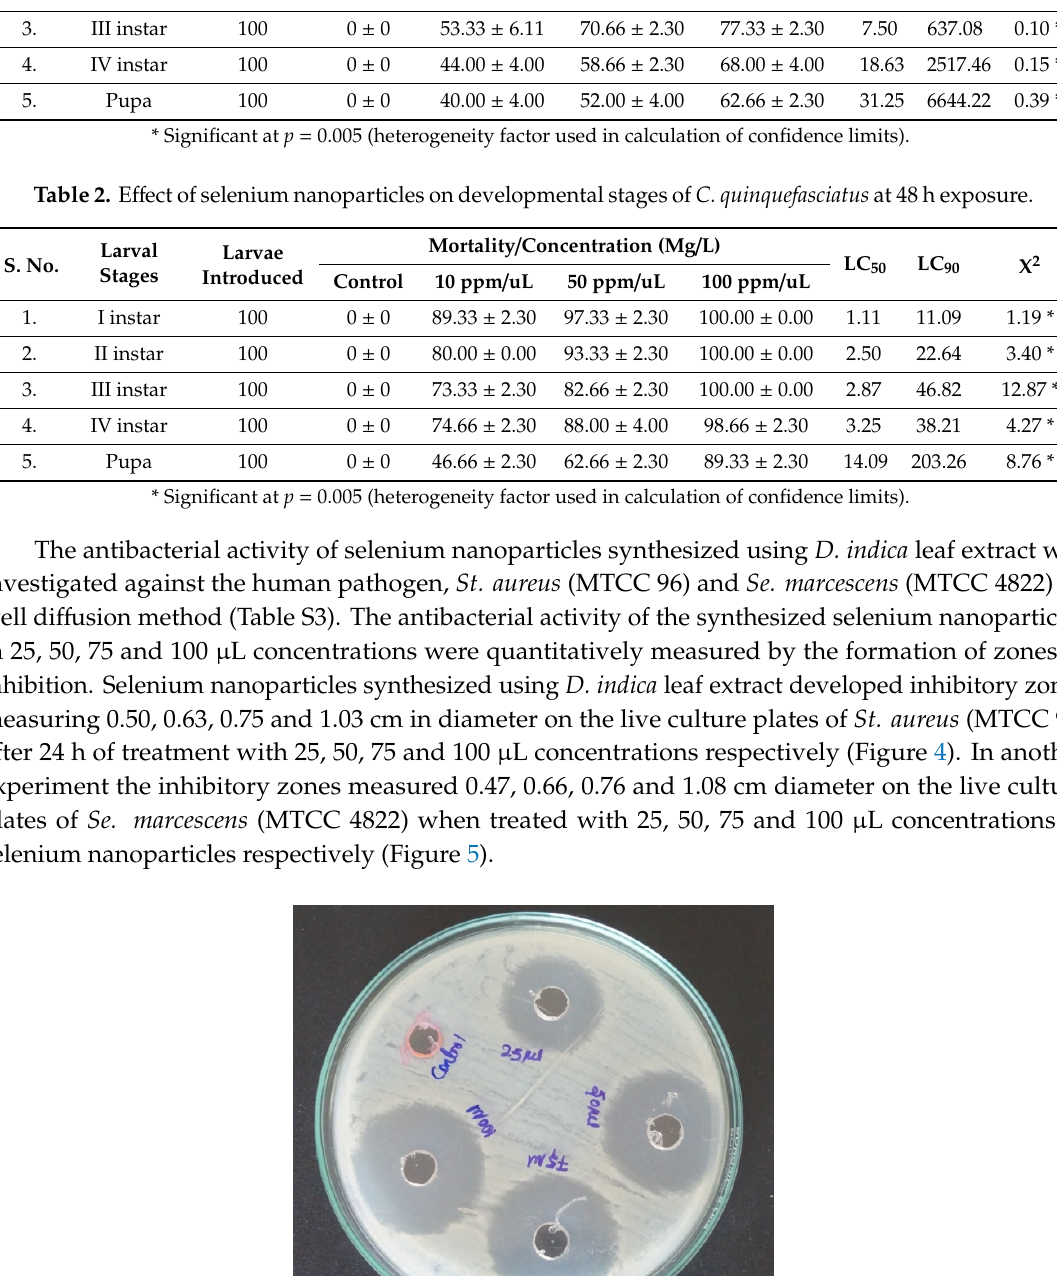
Table 1. E ff ect of selenium nanoparticles on developmental stages of A. aegypti at 48 h exposure. S. No.